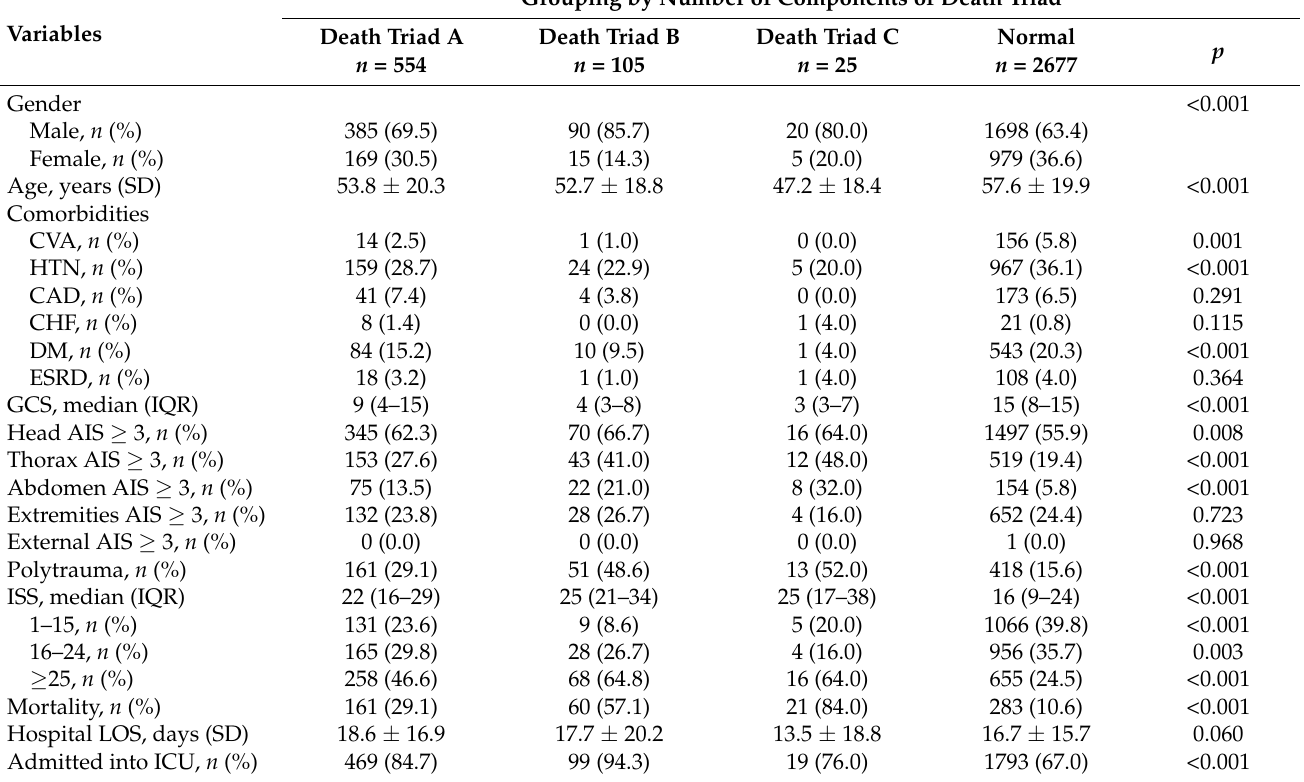
Table 1. The trauma patients grouped according to the number fit in the components of the death triad. The patients with one, two, and three items that fit in the components of the death triad were allocated into the group of death triad A, B, C,